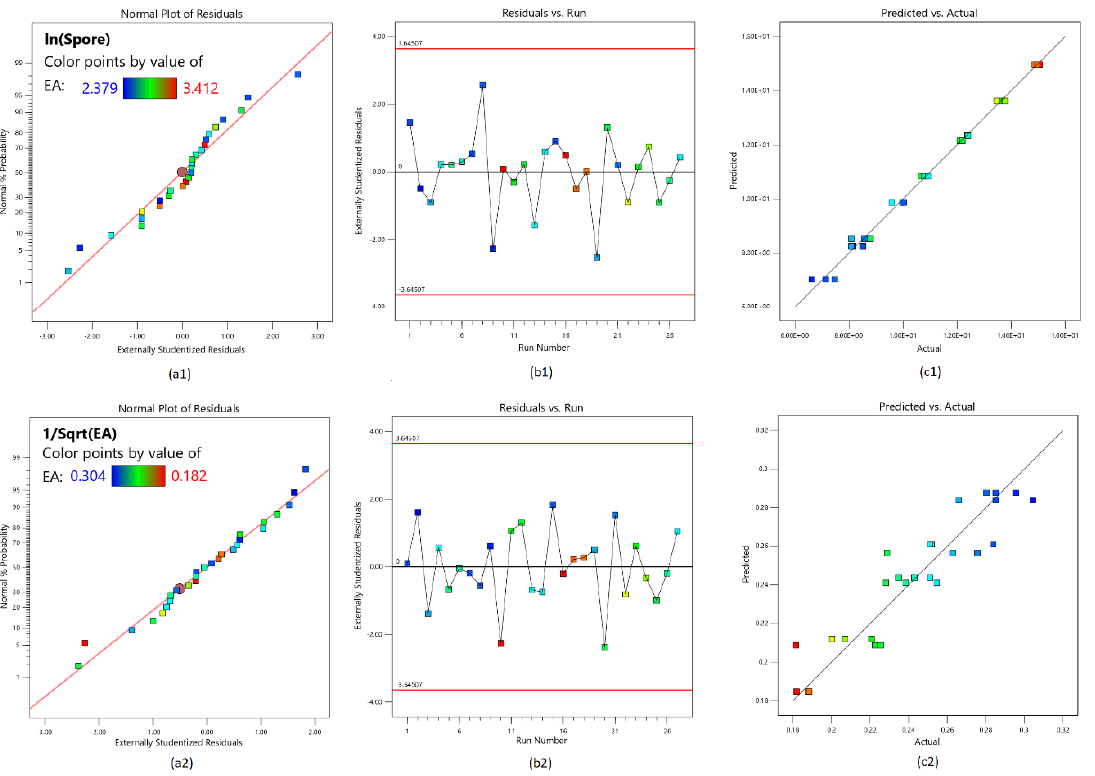
Figure 2. Analysis of the quadratic models of the transformed responses for spore count (upper part, a1 , c1 ) and enzymatic activity (lower part, a2 , c2 ) per gws. ( a1 , a2 ) Normality of the residuals for the models shown in Equations (2) and (3), respectively. ( b1 , b2 ) Student’s t external distribution of the residuals. ( c1 , c2 ) Correspondence between the real values of the responses with the values obtained with the models shown in Equations (2) and (3), respectively.